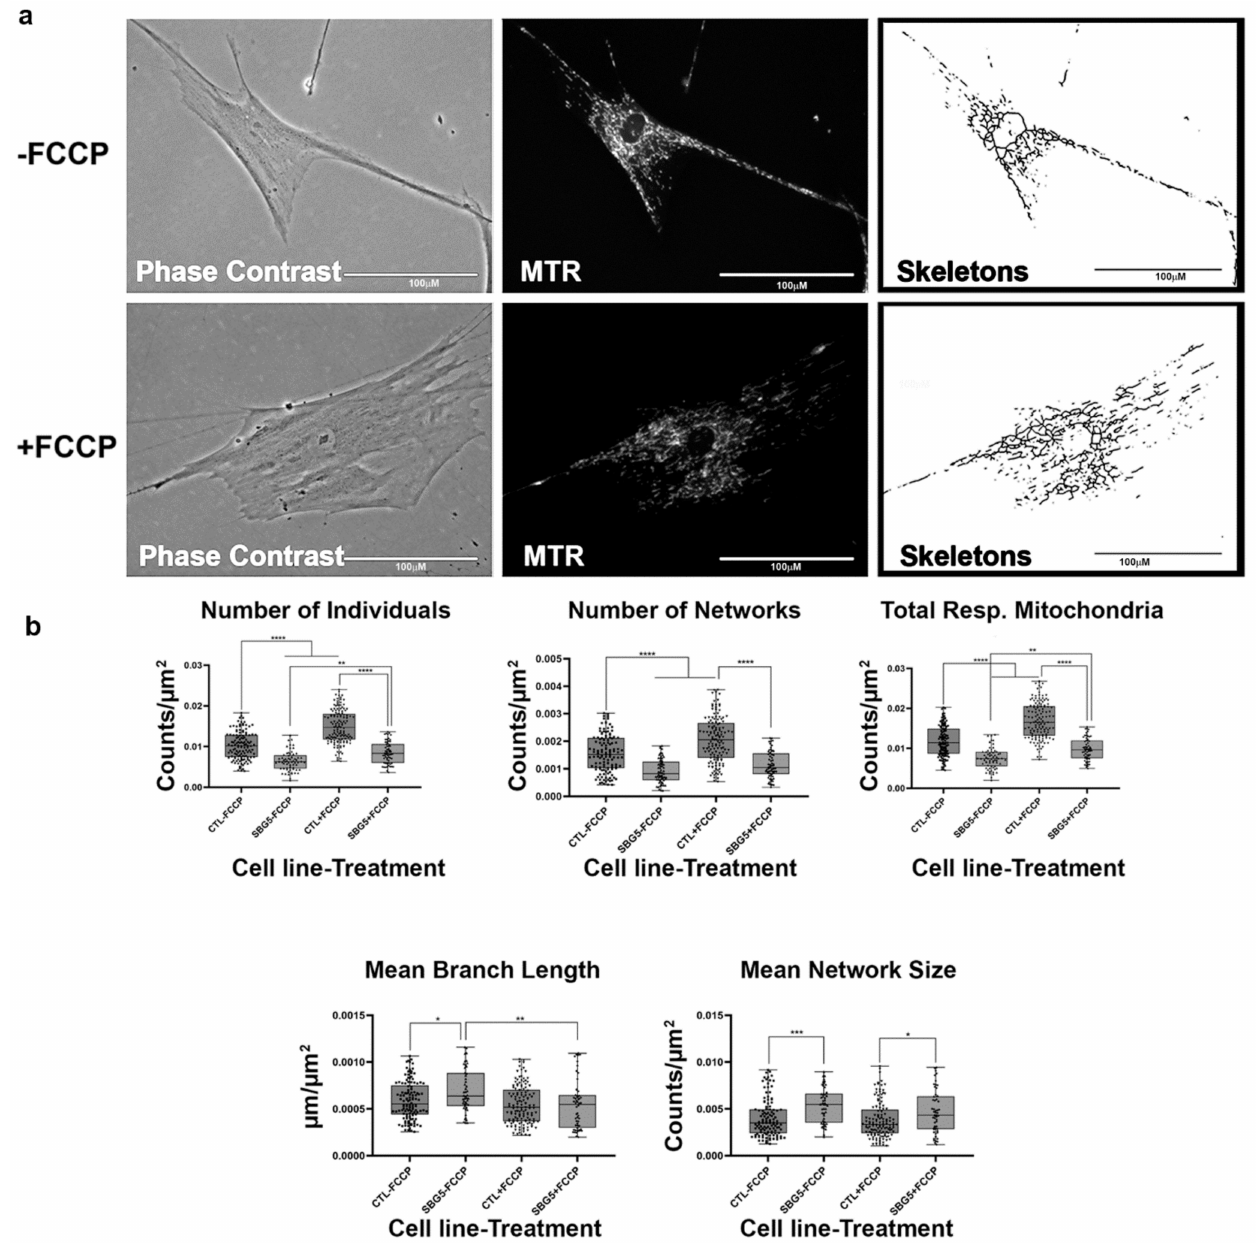
Figure 7. Mitochondrial morphology of SBG5 fibroblasts in the absence and presence of FCCP. ( a ) Representative images of SBG5 fibroblast cell lines stained with MTR. The top images are phase contrast, RFP, and skeletonized images of SBG5 fibroblasts without FCCP treatment. The bottom images are phase contrast, RFP, and skeletonized images of SBG5 fibroblasts with FCCP treatment. ( b ) The amount of actively respiring mitochondria in SBG5 fibroblasts is lower than those of the healthy control BJ fibroblasts. The significantly lower number of individuals, networks, and total respiring mitochondria in the SBG5 fibroblasts support this observation. The SBG5 fibroblasts also have hyperfused mitochondria, as they have longer branches and more branches within their networks. All data are representative of 10–14 images taken from three independent dishes per treatment group. The bars represent minimum and maximal values, and each black dot represents different data points. **** p < 0.0001, *** p < 0.001, ** p < 0.01, * p < 0.05. Scale bar = 100 µ